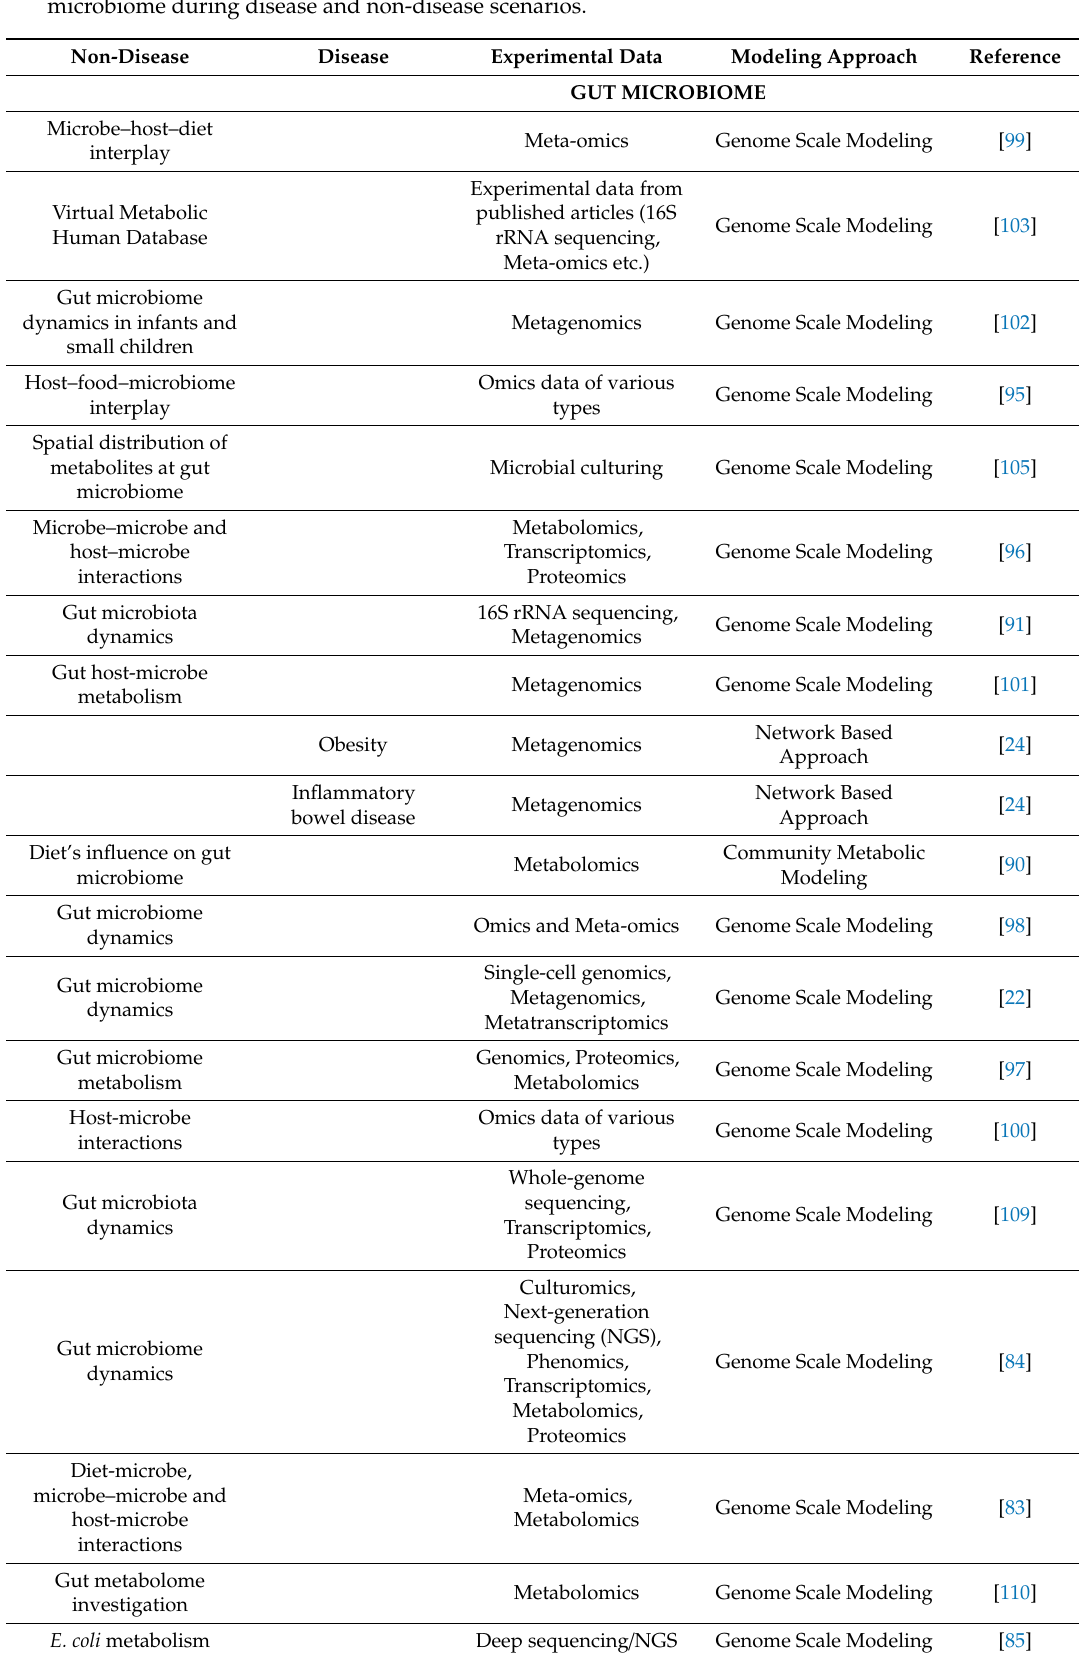
Table 1. Summative table of all the modeling studies performed on Gut, Oral, Skin and Vaginal microbiome during disease and non-disease